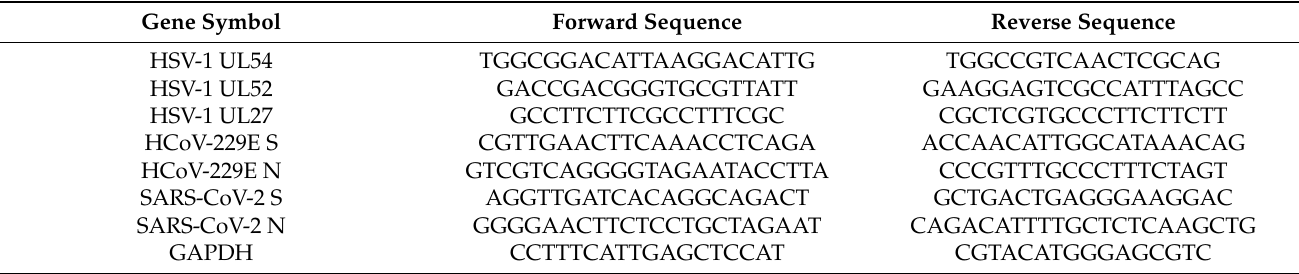
Table 1. Primers for viral genes used in Real-time